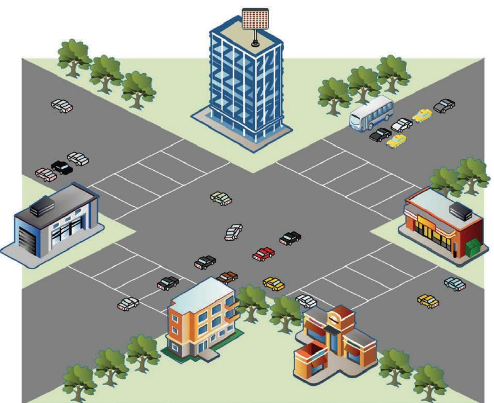
Figure 1: MU-MIMO transmission scenario in an urban